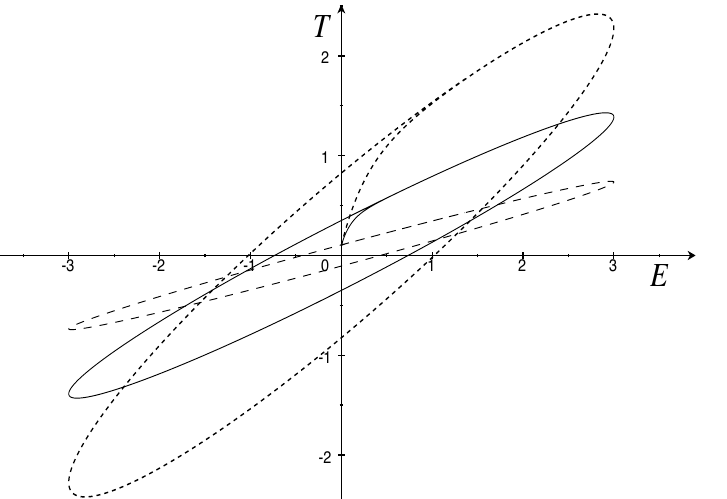
Figure 1. Cyclic responses in the ( E , T ) -plane under sinusoidal stretching with λ = 3, G 0 = 4 and H = 0.1 (dashed), H = 0.4 (solid), H = 0.7